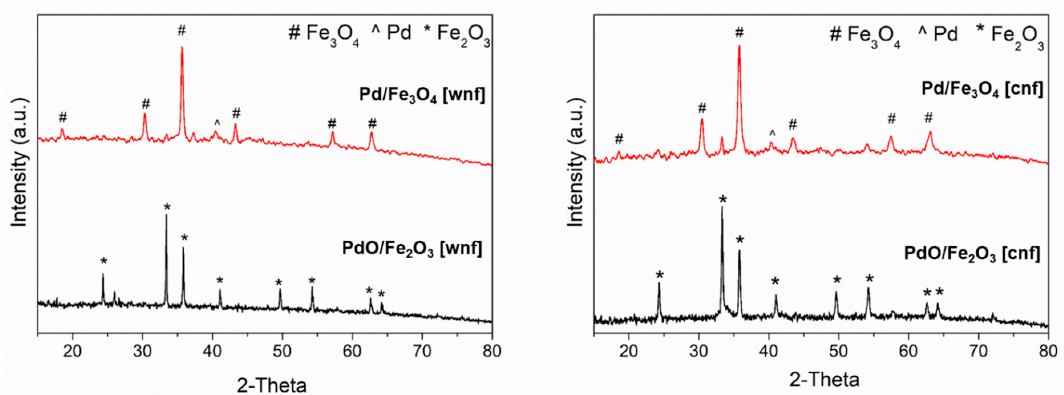
Figure 4. XRD spectra of investigated Pd-based iron oxide nanofiber catalysts.